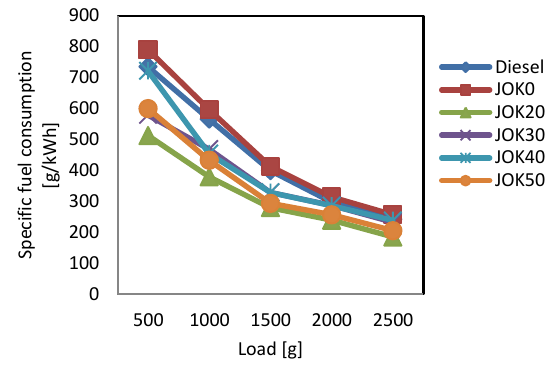
Fig. 3. Variation of SFC for JOK blends with increase in